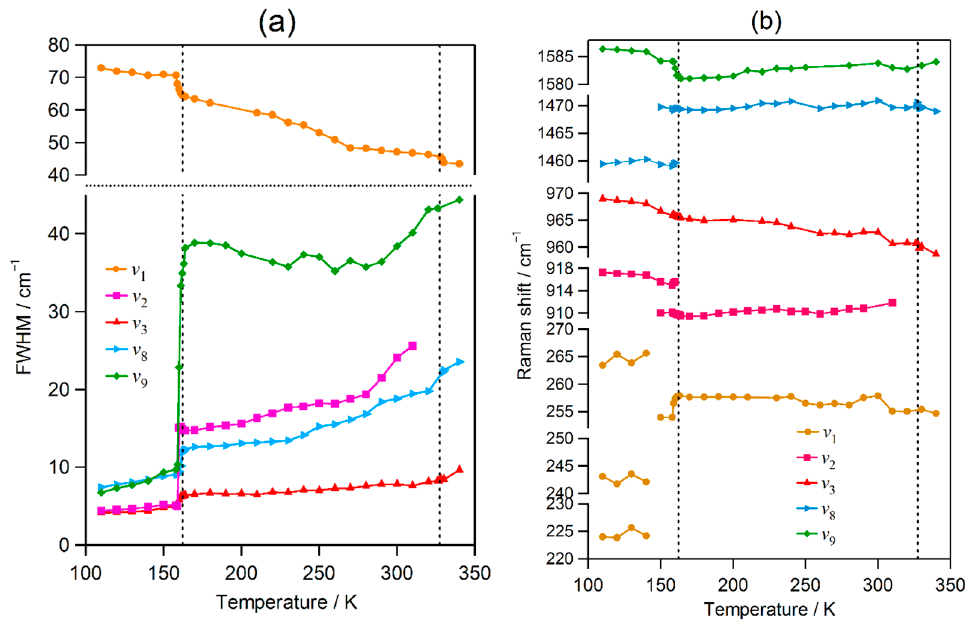
Figure 4. Temperature-dependent evolution of the ( a ) widths and ( b ) peak positions of the Raman bands of MAPbI 3 .